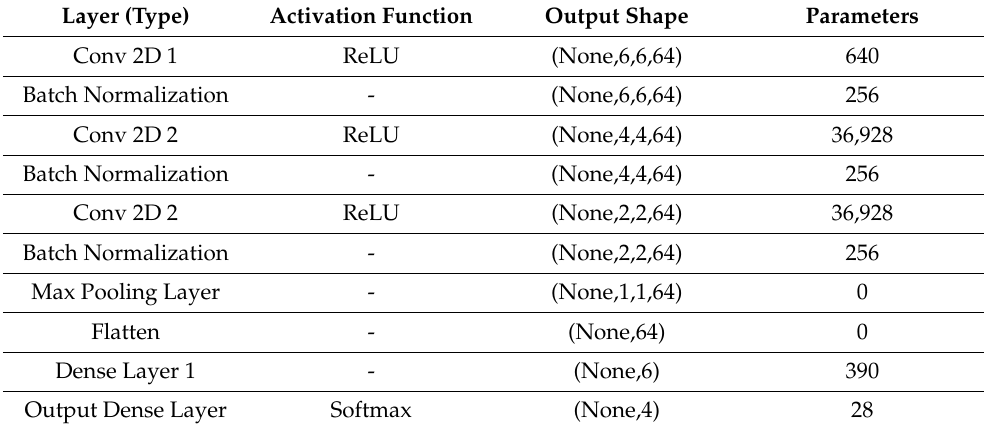
Table 1. Overview of the customized CNN architecture used in the present